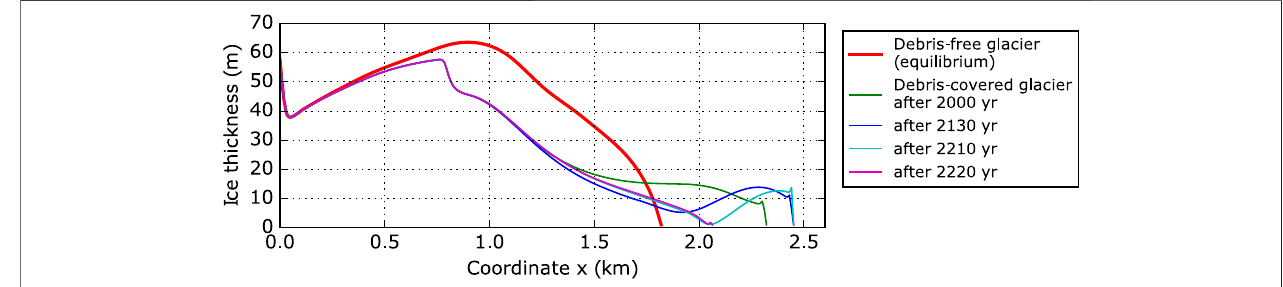
FIGURE7| Illustrationofglacierconditionsfortheerraticoscillationstateoftheglaciersystemwith ζ (cid:1) 0.5 % and β 2 (cid:1) 0.01.Fourtypicalphasesarecaptured:frontal advance (green), further frontal advance and thinning in the low- fl ux area (blue), glacier state just before the collapse (cyan), new geometry just after the collapse (magenta).